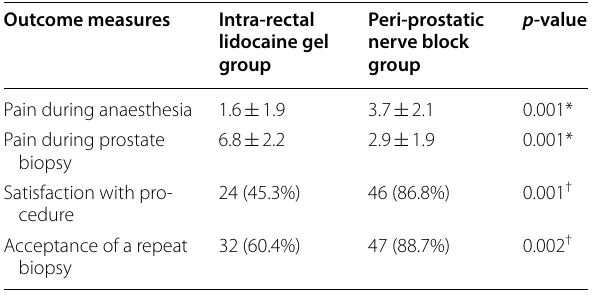
of outcome measures between the intra-rectal lidocaine gel group and the peri-